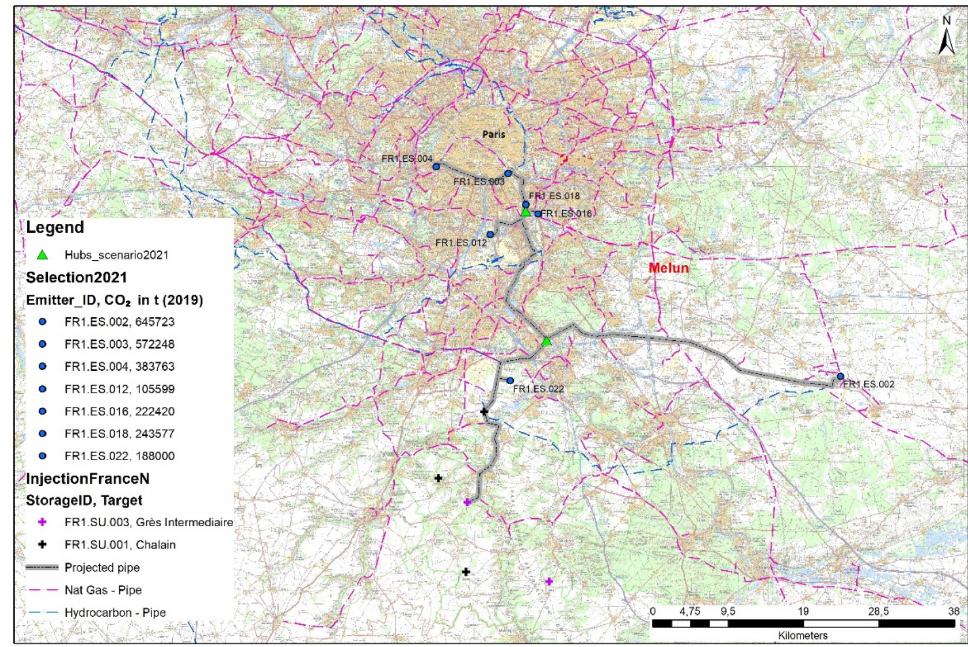
Figure 8. Spatial conditions for clusters and the transport network of CO 2 . New pipelines following existing ones are considered “projected pipelines”. Storage locations are represented by simulation injection points carried out in the France Nord project (FR1.SU.003 and FR1.SU.001) for the Keuper Fm. and for the Dogger Fm.; storage location is on the emission point FR1. ES.002.